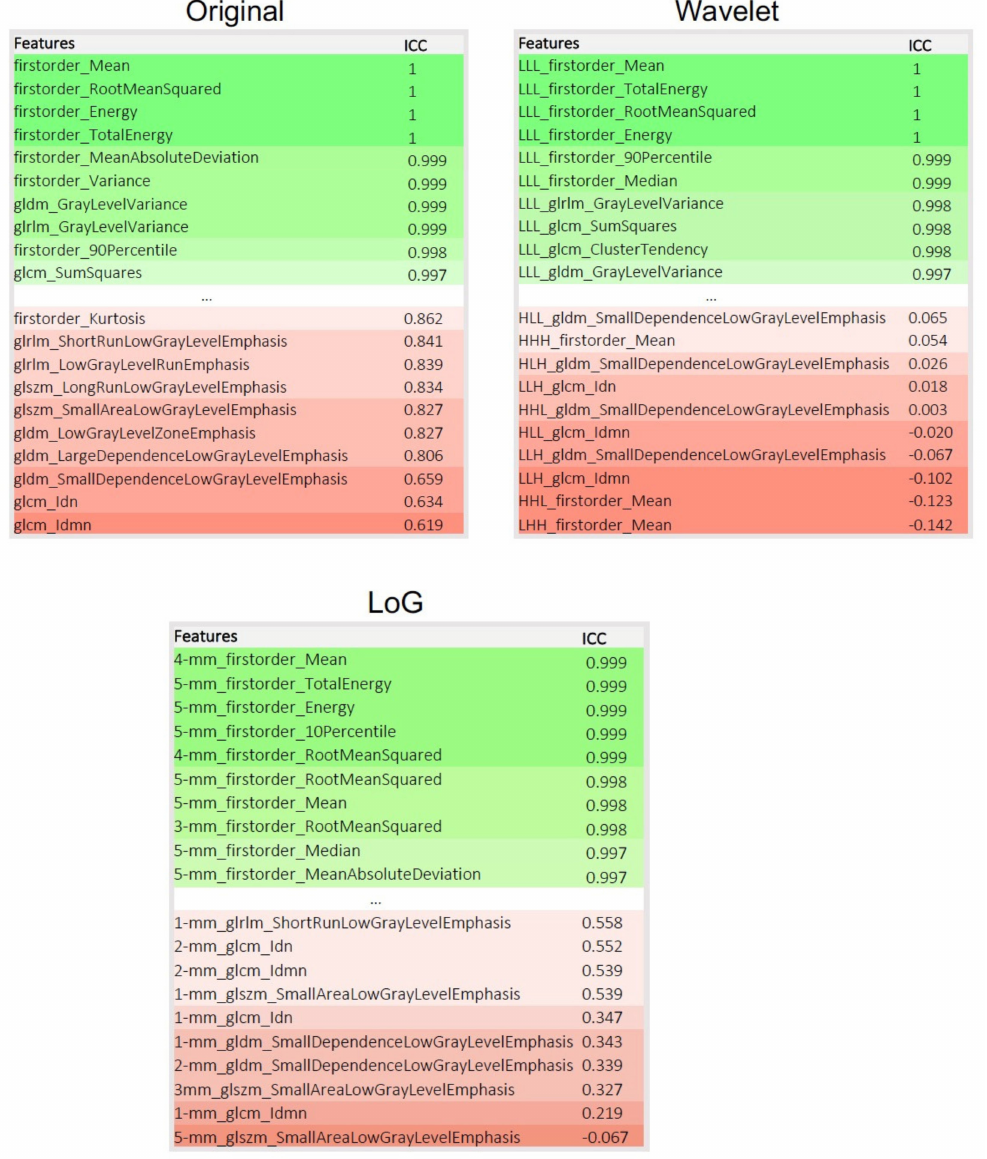
Figure 5. Visualization of the ten most and least repeatable FET PET radiomics features for the original (unfiltered) images, after wavelet and Laplacian of Gaussian (LoG) filtering. Feature names are shown next to the intraclass correlation coefficient (ICC) values. Calculations have been performed on the 14 mL volume spherical tumor volume-of-interest representing the average tumor volume in our